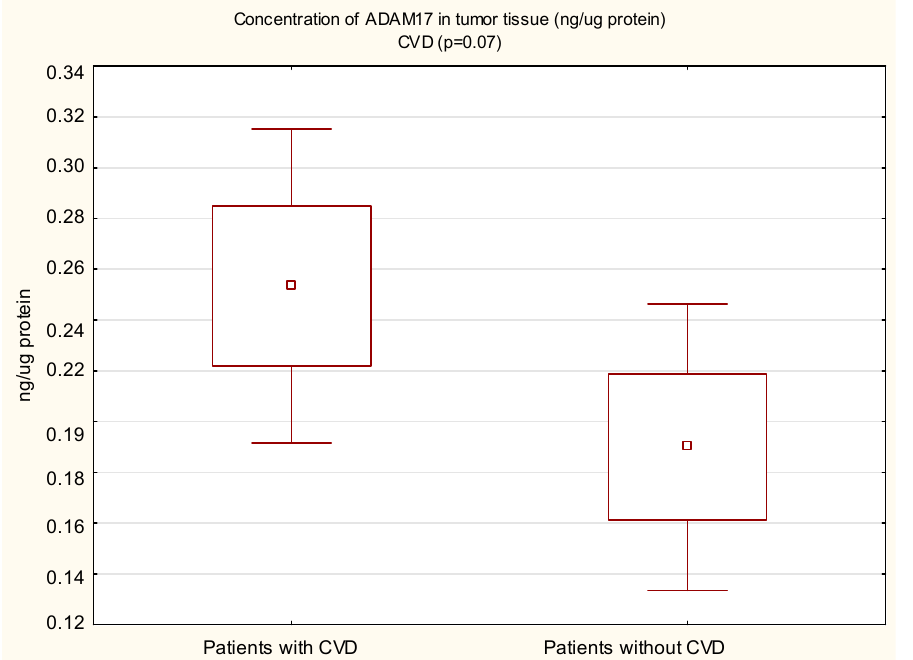
Figure 3. Concentration of ADAM17 protein in tumor tissue in CRC patients with and without cardiovascular diseases (CVD).